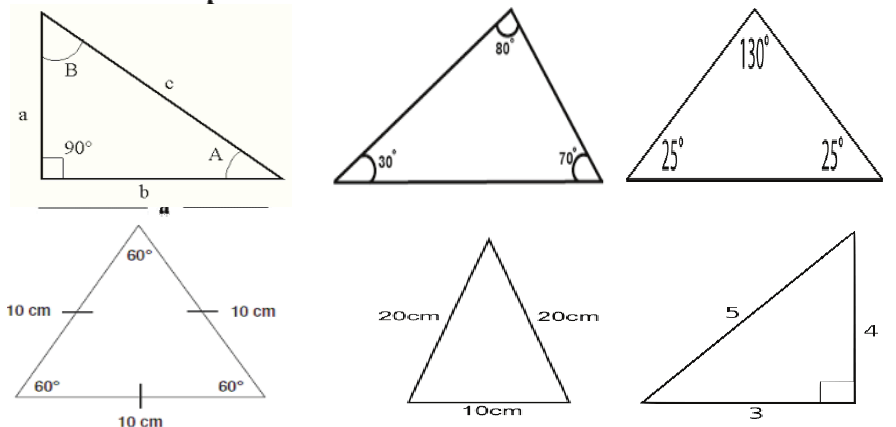
Figure 1. Selected animation frames and corresponding narration of triangle’s types by angles and sides, and a way to calculate triangle's